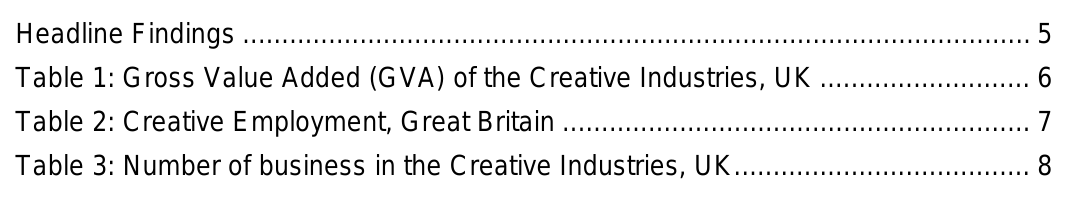
Table 1: Gross Value Added (GVA) of the Creative Industries, UK ........................... 6 Table 2: Creative Employment, Great Britain ............................................................ 7 Table 3: Number of business in the Creative Industries, UK ...................................... 8